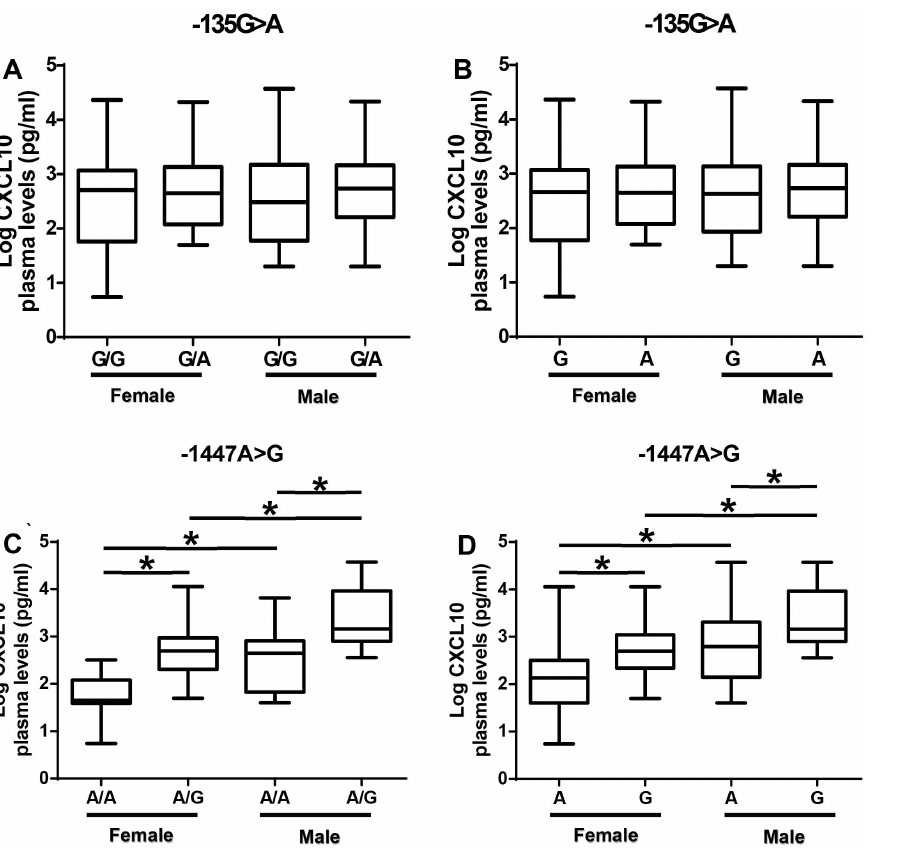
Figure 4. Association between 2 135G . A and 2 1447A . G polymorphism with plasma CXCL10 levels stratified by gender. (A) Effect of 2 135G . A polymorphism genotype on plasma CXCL10 protein levels stratified by gender. (B) Effect of 2 135G . A polymorphism allele on plasma CXCL10 protein levels stratified by gender. (C) Effect of 2 1447A . G polymorphism genotype on plasma CXCL10 protein levels stratified by gender. (D) Effect of 2 1447A . G polymorphism allele on plasma CXCL10 protein levels stratified by gender. Box plot represent log-transformed medians with 25 th and 75 th percentiles, bars for 10 th and 90 th percentiles. The distribution of plasma CXCL10 expression levels among females and males segregated according to the genotype was analyzed with the Kruskal-Wallis test, followed by a Dunn’s multiple-comparison, with p , 0.05 considered significant. Asterisk (*) indicates a significant difference (p , 0.05).